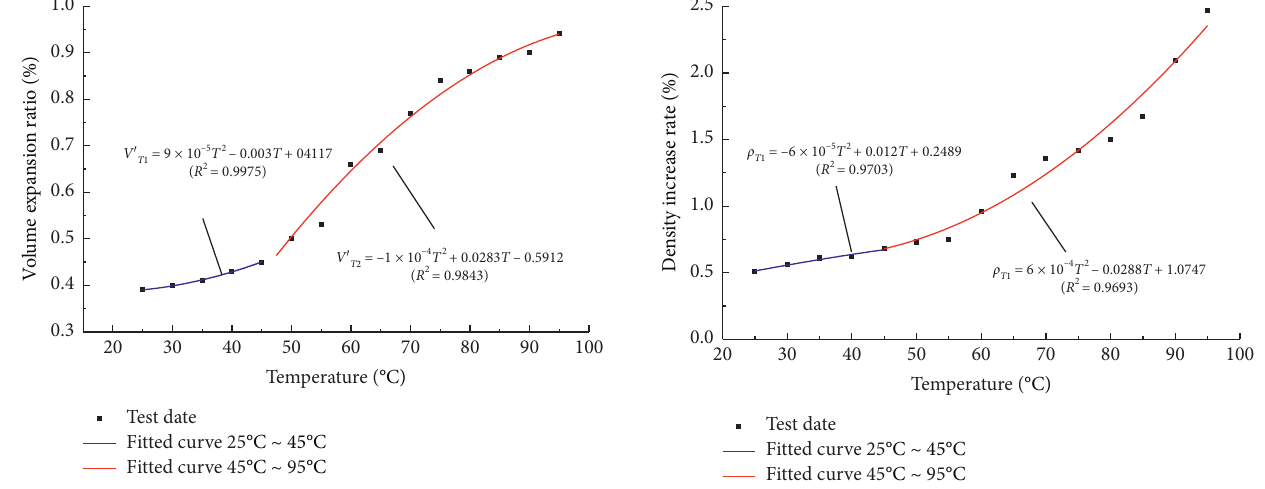
Figure 6: Density changes with water bath temperature. Figure 4: Volume changes with water bath